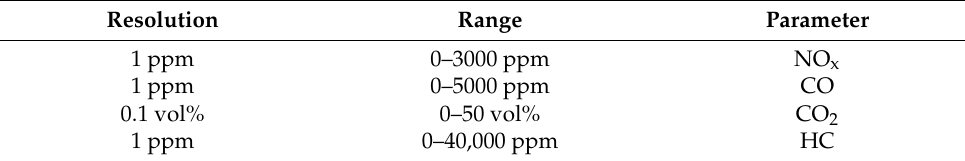
Figure 1. Schematic arrangement of the engine test bed: ( a ) diesel engine, ( b ) dynamometer, ( c ) gas analyzer, ( d ) EGR system, ( e ) thermometer, ( f ) fuel tank, ( g ) air tank, ( h ) transducer. Table 4. Specification of the Testo 350 emission